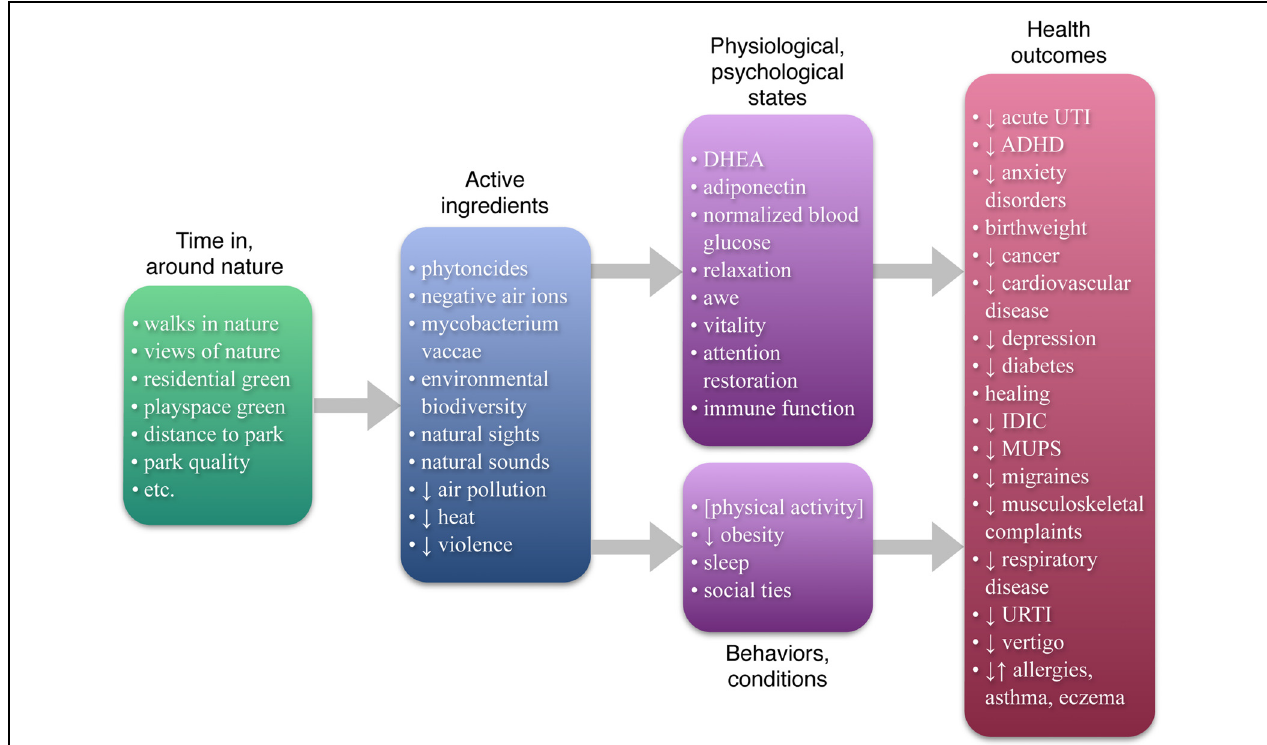
FIGURE 1 | The nature-health link: filling in the details. This Figure summarizes the state of the scientific literature on nature and health, listing (1) the “active ingredients” in nature that have been identified as having impacts on health or health antecedents; (2) physiological/psychological states, behaviors, and conditions tied to both nature and health; and (3) specific health outcomes that have been tied to nature (controlling for socioeconomic variables). Note that